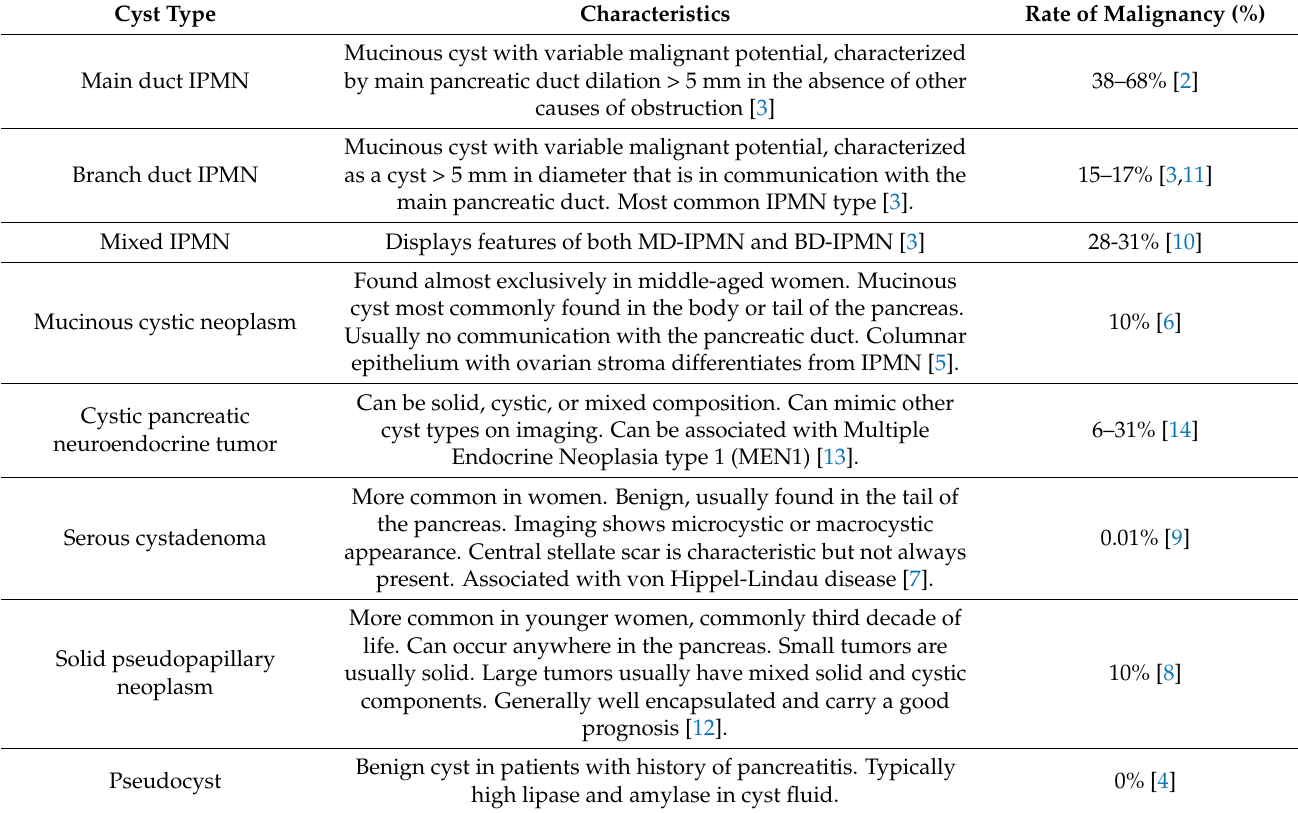
Table 1. Type, characteristics, and malignant potential of pancreatic cystic